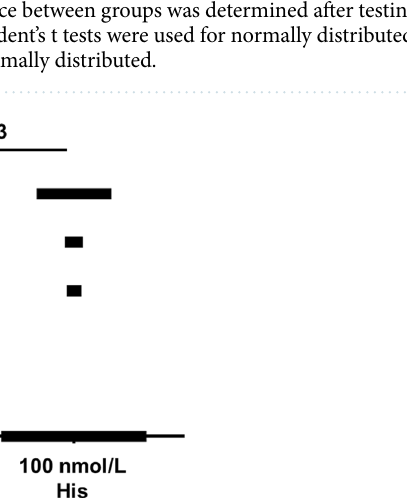
Figure 4. Exogenous histamine does not impact engorgement when blood is provided as an artificial bloodmeal. Three groups of 20 A. aegypti were fed either normal defibrinated sheep’s blood (--) or defibrinated sheep’s blood with 100 nmol/L histamine using a Hemotek artificial membrane feeder for 30 min. Mosquito engorgement was quantified on a 0–5 scale. Statistical significance between groups was determined after testing for normal distribution using the Kolmogorov–Smirnov test. Student’s t tests were used for normally distributed data. Mann–Whitney tests were used for data that was not normally